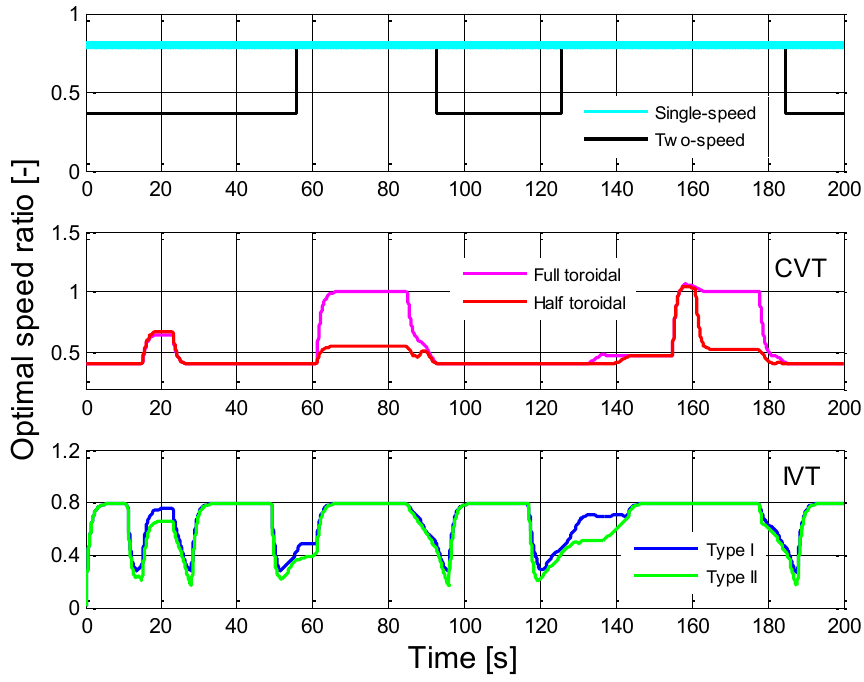
Figure 14. Optimal speed ratios of 2G, CVTs, and IVTs as functions of time along the